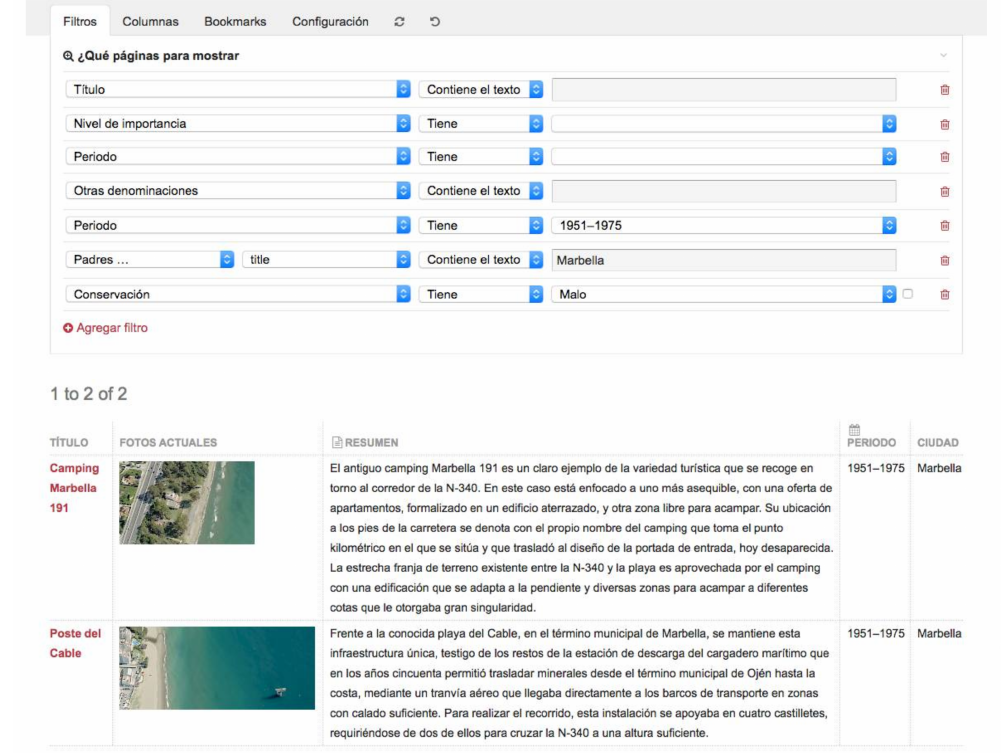
Figure 6. Custom multicriteria search engine. “Lister Pro”, a ProcessWire premium